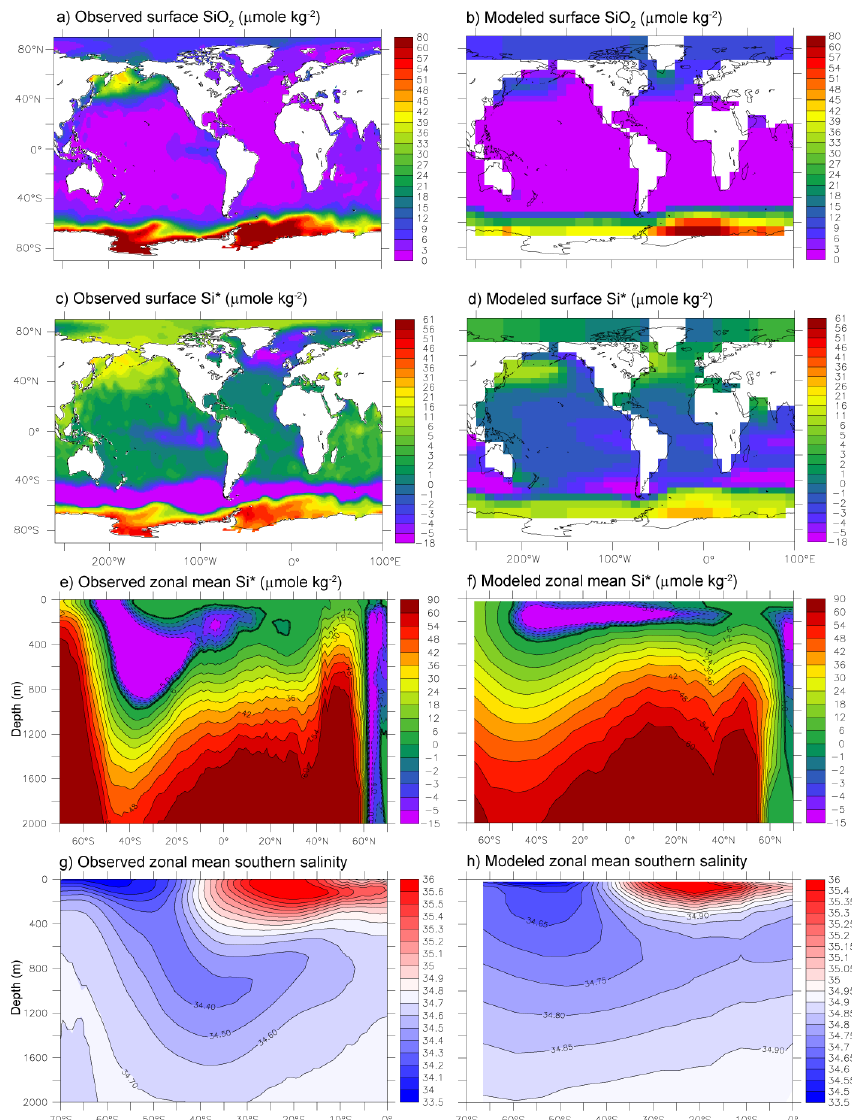
Fig. 10. Observed and model-simulated annual mean silica cycle diagnostics and salinity: (a, b) surface Si(OH) 4 ; (c, d) surface Si* con- centration; (e, f) global zonally averaged Si* concentration; (g, h) zonally averaged, Southern Hemisphere salinity. Left column shows observations based on the World Ocean Atlas 2009 (Antonov, 2010; Garcia, 2010). The right column shows model results from MESMO 2. Surface indicates top 45m. Negative Si* indicates Si deficiency; see